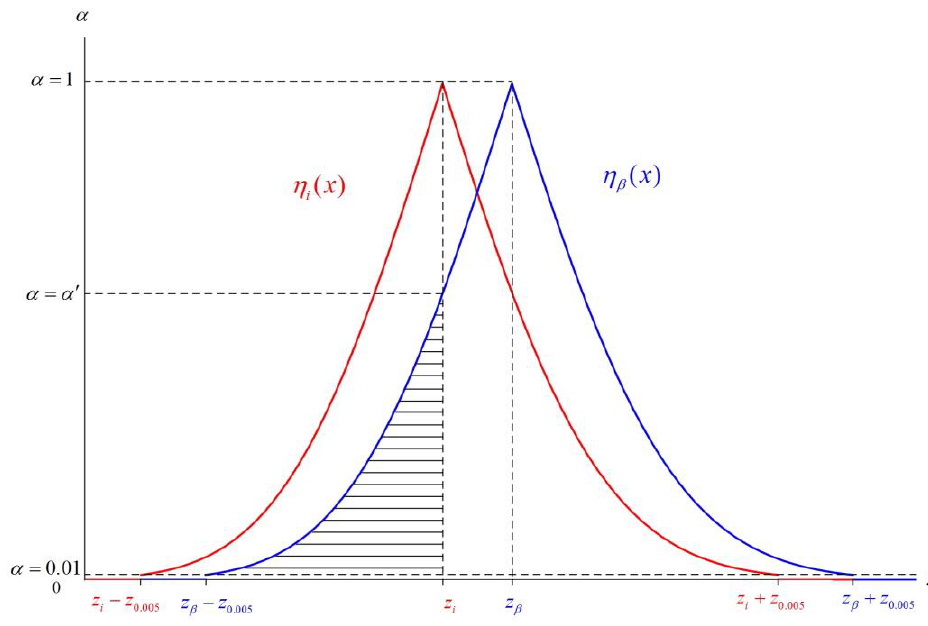
Figure 2. Membership functions of η i ( x ) and η β ( x ) .